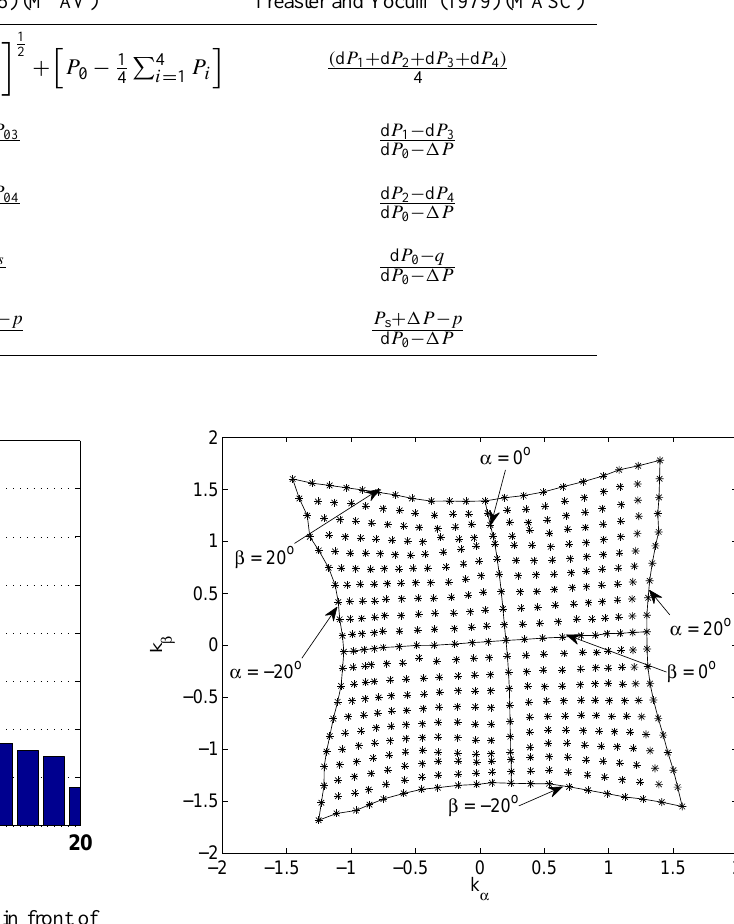
Fig. 7. Two-dimensional plot of k β over k α . The figure shows the nonlinearities that are larger for higher airflow angles α and β